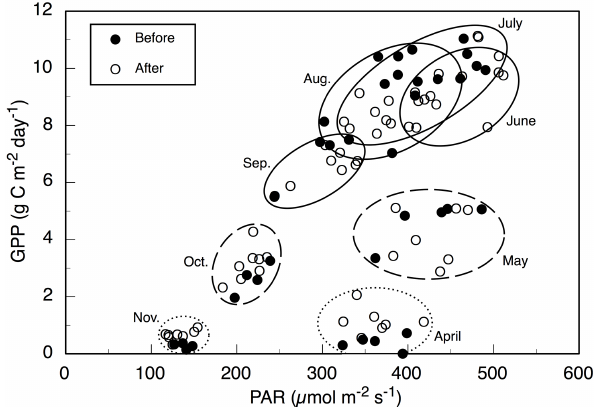
Figure 8. Relationships between monthly mean gross primary pro- duction (GPP) and monthly mean photosynthetically active radia- tion (PAR) in the snow-free season. Each month’s data are enclosed by ellipses. Black and white circles represent monthly data before and after the disturbance, respectively. The snow-free season is sep- arated into three periods. The elliptical solid, broken, and dotted lines indicate the growing season (June–September), transition sea- son (May and October), and leafless season without snow (April and November), respectively.